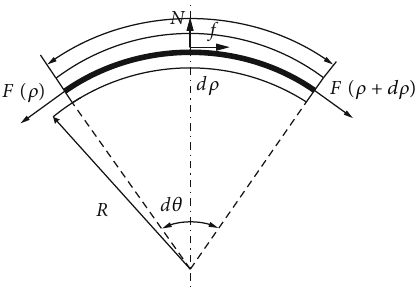
Figure 5: The in fi nitesimal model of the force